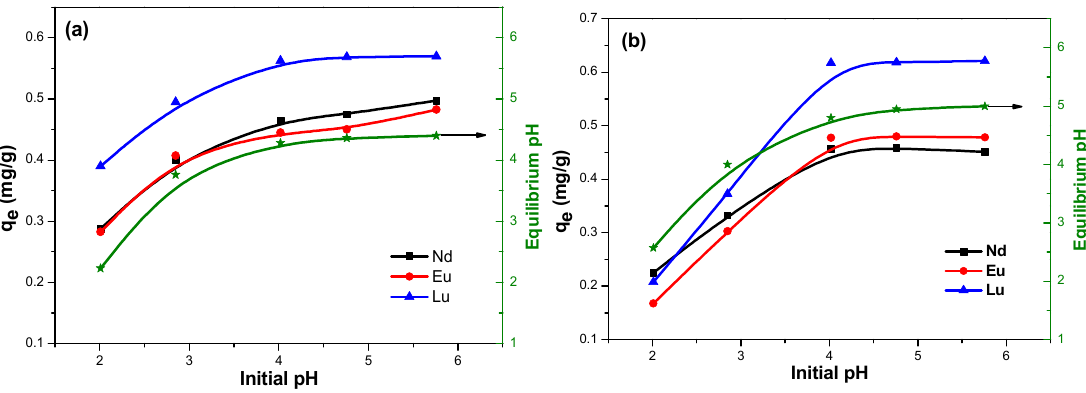
Figure 8. Effect of initial pH on Nd 3+ , Eu 3+ and Lu 3+ adsorption on halloysite ( a ) and illite ( b ). The equilibrium pH levels after Nd 3+ , Eu 3+ and Lu 3+ adsorb on halloysite and illite were determined (Figure 8). It shows that the equilibrium pH levels diverge from initial pH due to the buffer performance of halloysite and illite. Moreover, the equilibrium pH levels reach a platform when initial pH is higher than 4, which is same as the tendency of q e . The results indicate that q e is influenced by equilibrium pH rather than initial pH. However, the equilibrium pH levels of halloysite and illite are lower than their buffer pH (Figure 5), implying that the adsorption of RE ions is beneficial for H + fleeing from clay